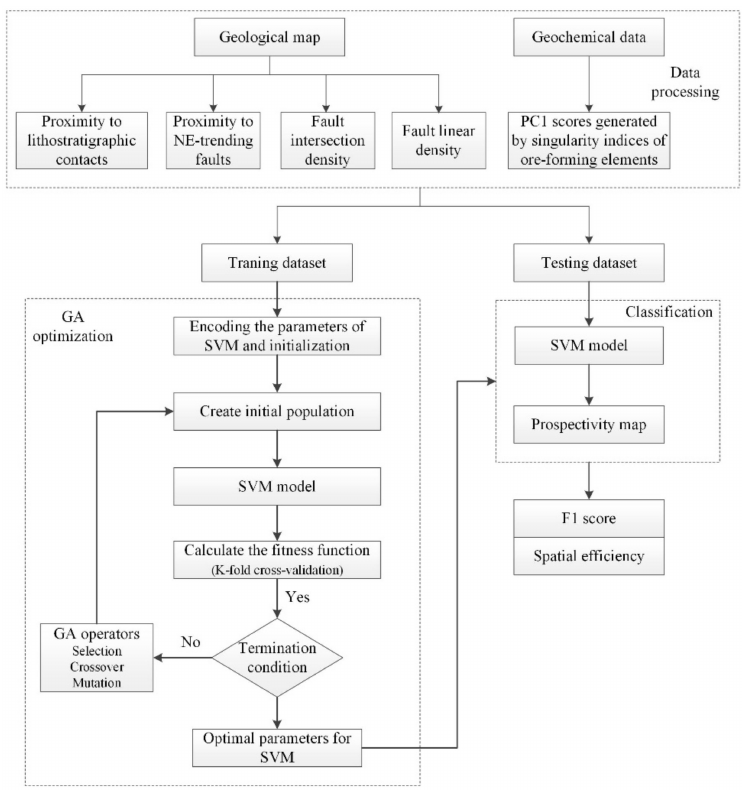
Figure 1. The procedure involved in the GA–SVM model for